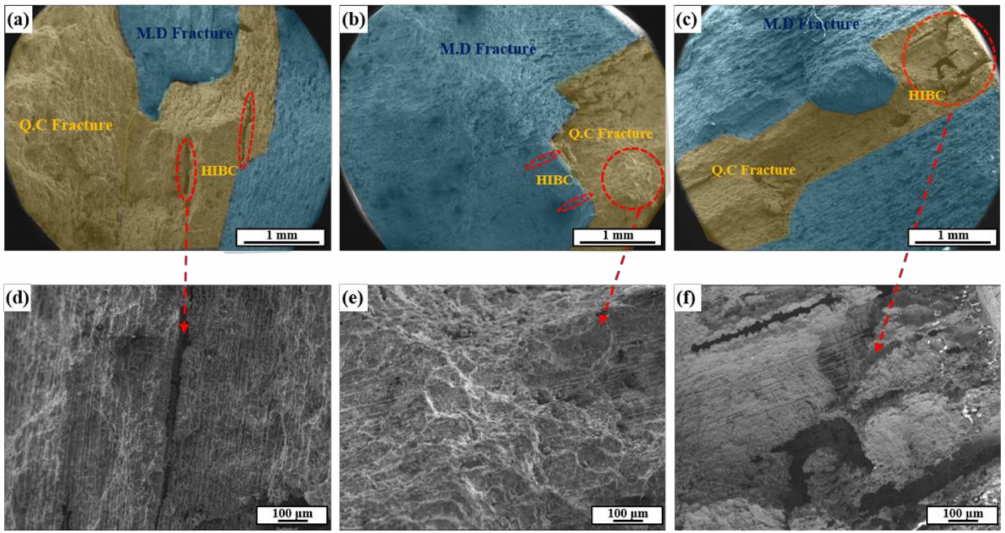
Figure 11. Fracture surface morphologies of the three samples after the SSC test: ( a ) Steel A, ( b ) Steel B, and ( c ) Steel C, and ( d – f ) magnified images of the circle marked on ( a – c ), respectively.